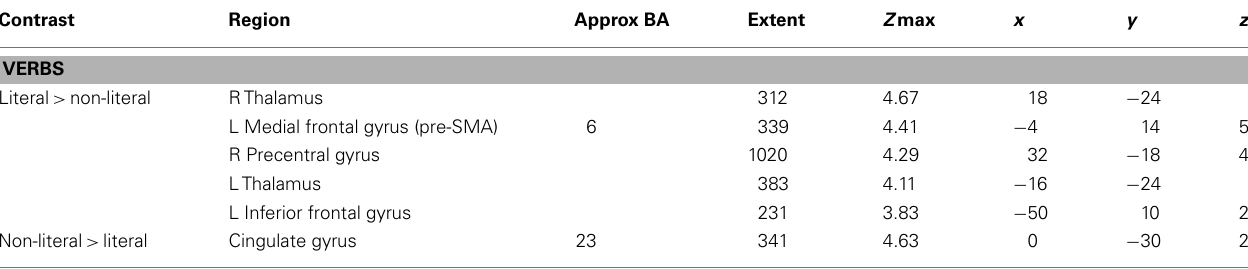
TableA2 |Additional whole brain analysis, with a less conservative